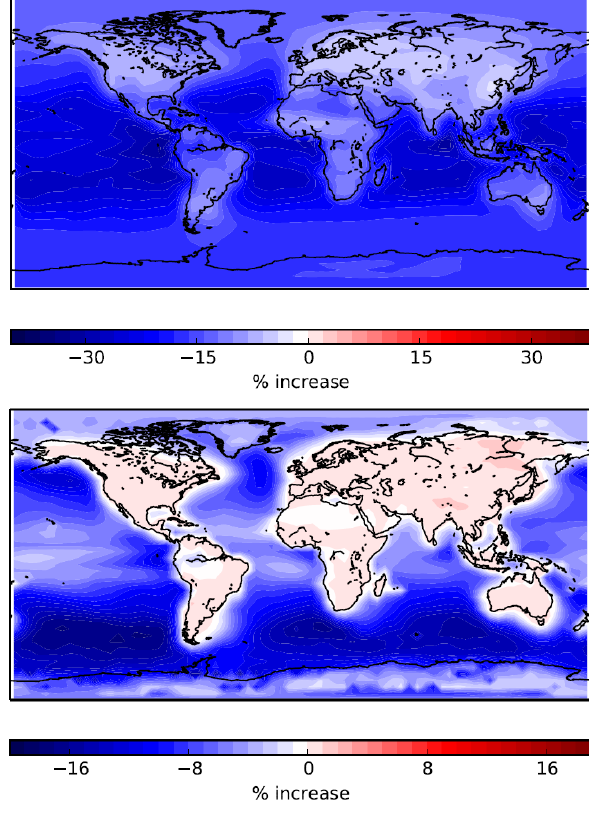
Figure 9. Percentage increase in (a) [PAN] and (b) [NO] of varying k (R5) from the IUPAC value ( k (R5) = 1.4 × 10 − 11 cm 3 molecule − 1 s − 1 ) to that of the